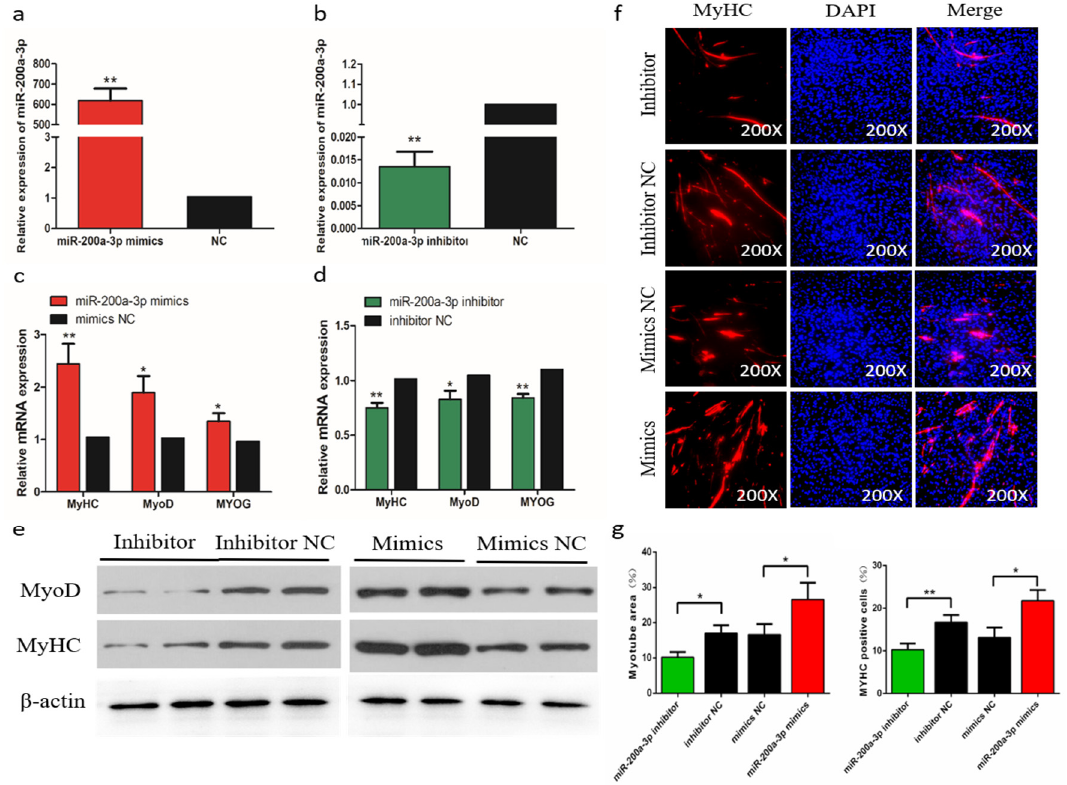
Figure 5. E ff ects of miR-200a-3p on the di ff erentiation of skeletal muscle satellite cells (SMSCs). ( a , b ) Expression of miR-200a-3p in SMSCs was monitored using qRT-PCR following transfection with a miR-200a-3p inhibitor or mimic. ( c , d ) The relative expressions of myogenic determination 1 (MyoD1), myosin heavy chain (MyHC), and myogenin (MyoG) mRNA in SMSCs di ff erentiated for 48 h. ( e ) Western blot detects protein levels of myogenic marker genes after inhibition and overexpression of miR-200a-3p. ( f ) Representative images of immunofluorescent staining of di ff erentiated SMSCs (200 × ). Myosin: Red, a molecular marker of myogenesis; DAPI: Blue, cell nuclei; Merge: The fusion of SMSCs into primary myotubes. ( g ) Myotube area (%) and MYHC positive cells (%) after transfection of miR-200a-3p mimics, miR-200a-3p inhibitors, or negative control (NC). Data are expressed as mean ± SEM ( n = 3). * p < 0.05; ** p < 0.01 vs. NC.